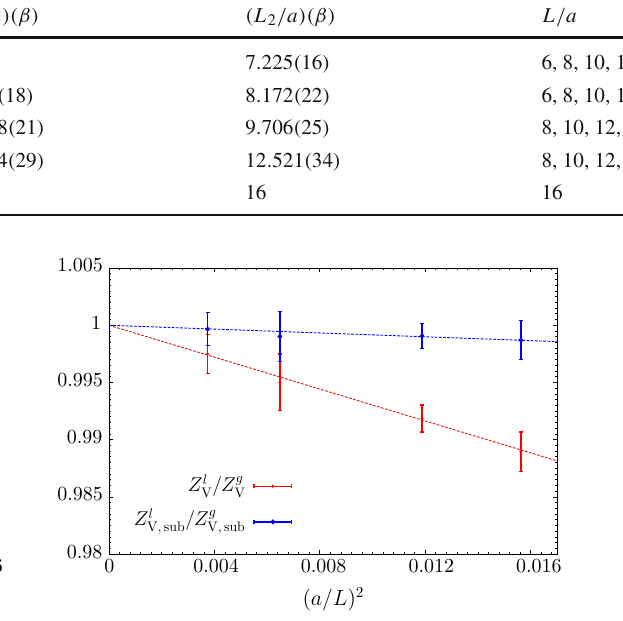
Fig. 5 Continuum limit of the ratios between the l and g definitions of Z A (left panel) and Z V (right panel) for the case of N f = 2 quark- flavours; the effect of subtracting the lattice artefacts from the Z -factors